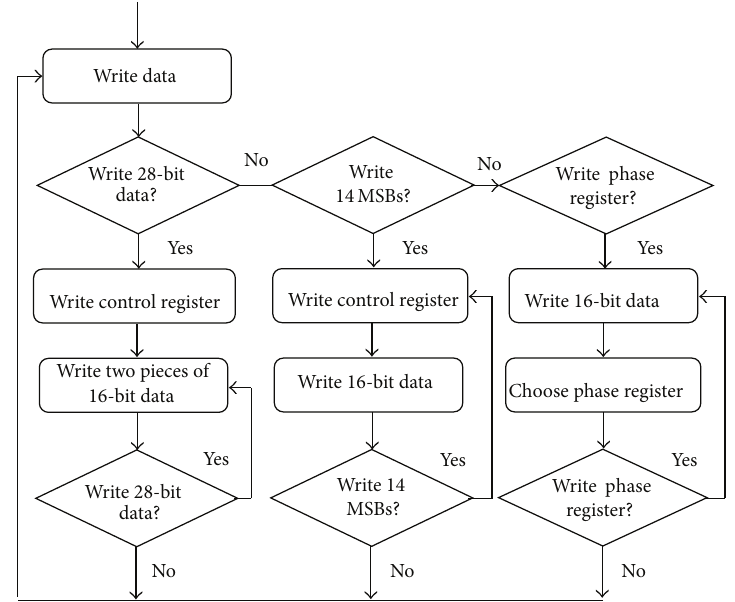
Figure 17: The block diagram of DDS writing data.